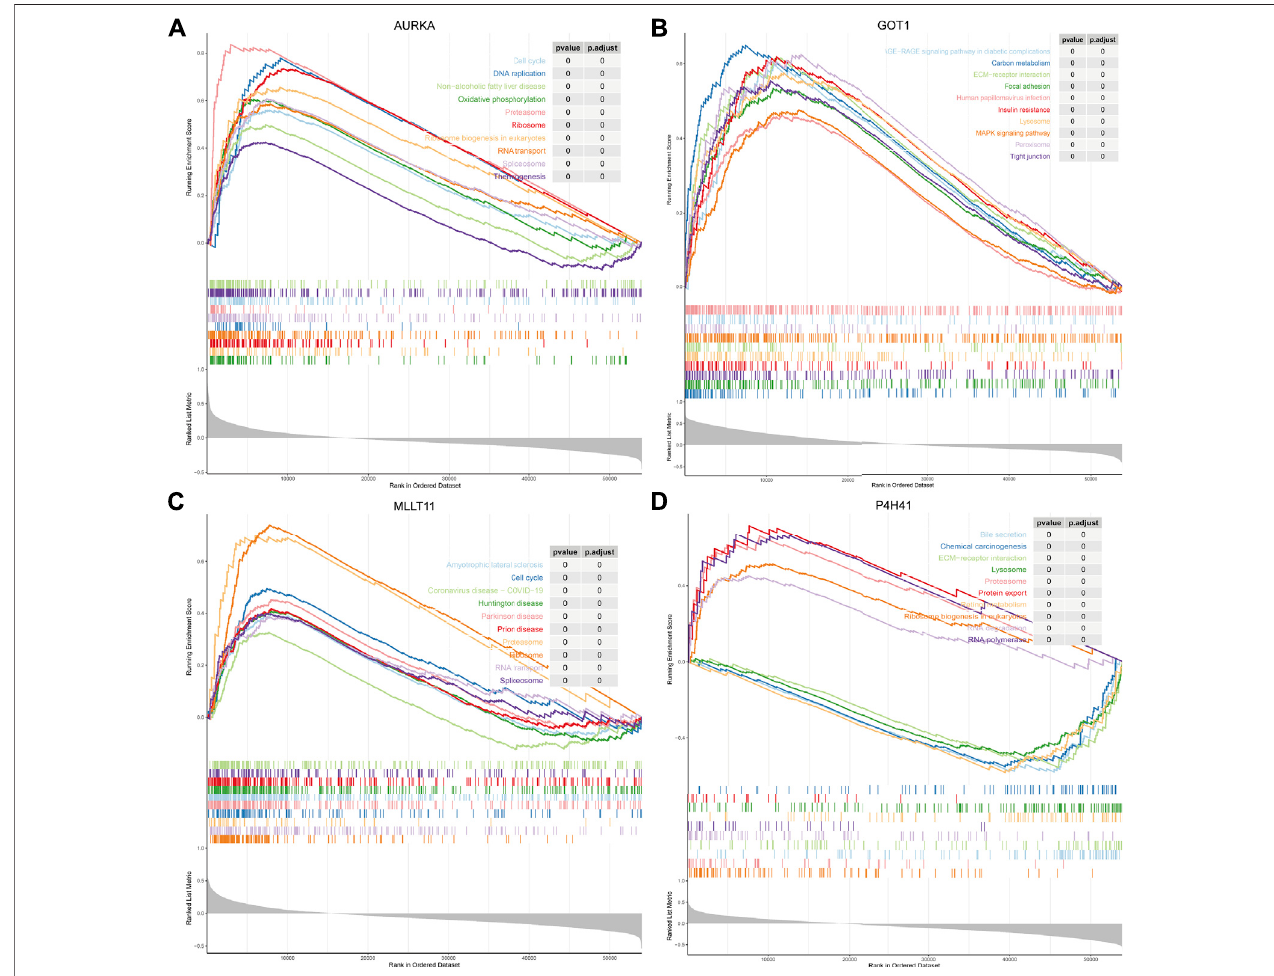
FIGURE 4 | GSEA of the prognostic biomarkers. GSEA explores related signal pathways of (A) AURKA; (B) GOT1; (C) MLLT11; and (D) P4H41.